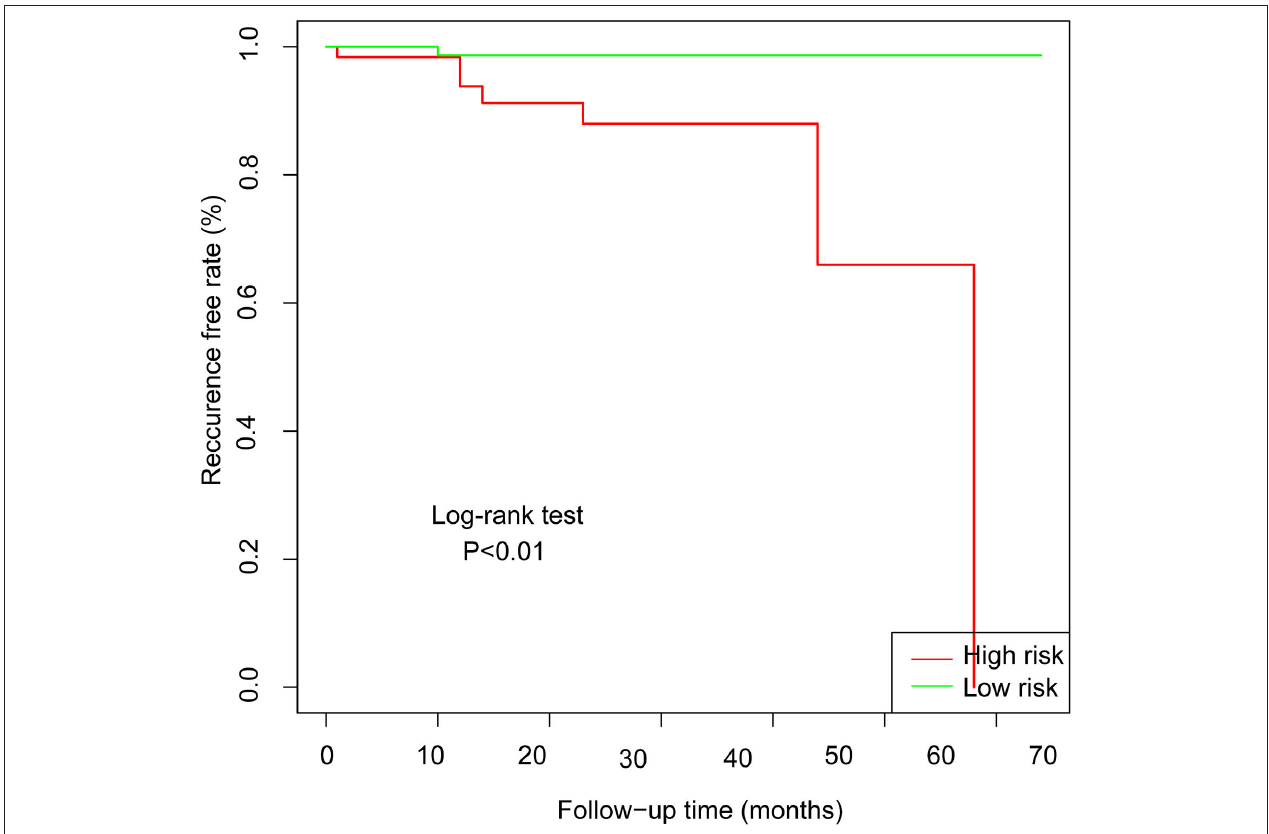
FIGURE 8 | Kaplan-Meier curves for low-risk and high-risk populations stratified by nomogram 1 in the validation